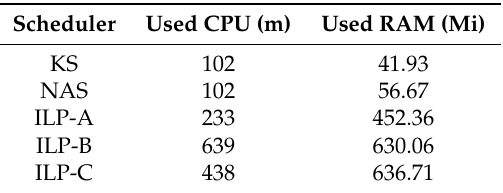
Table 7. The resource consumption of the different schedulers.